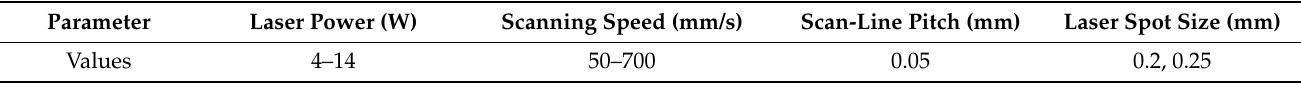
Table 1. Parameters of laser treatment of HA pellet